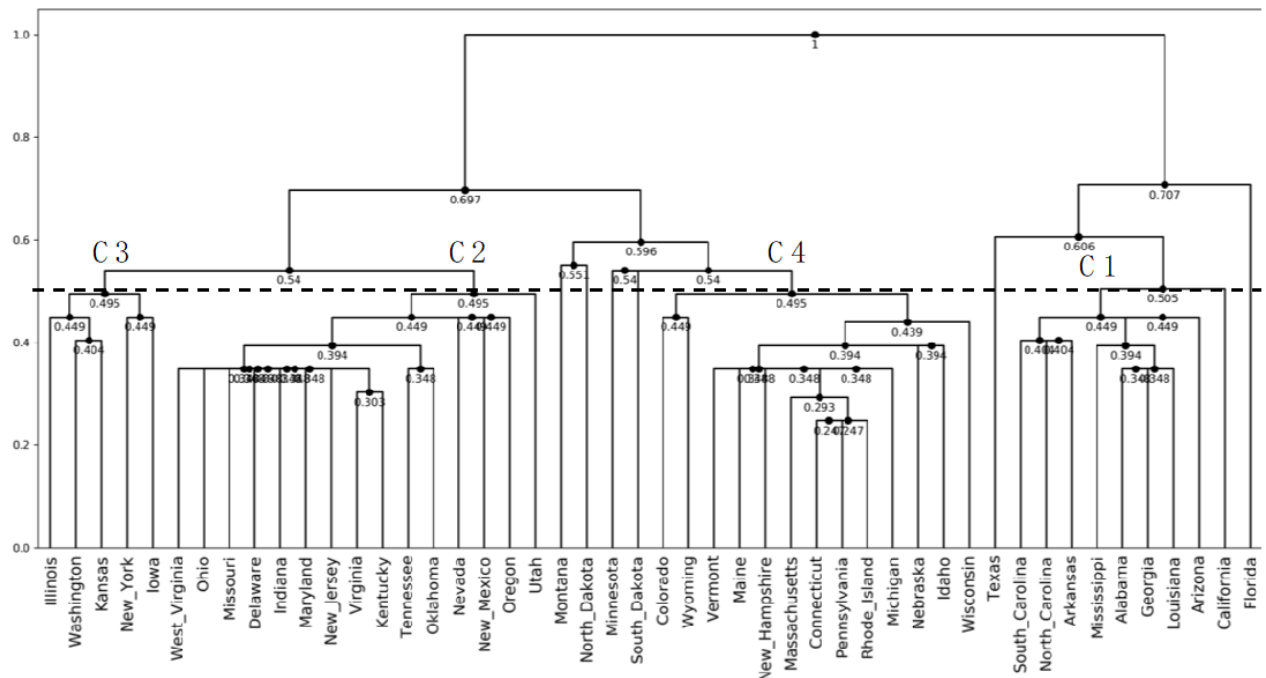
Figure 22. Clustering result of the US state weather data for February and November. Figure 23 is the scatter diagram of eleven distributions including four major clusters and seven outliers. Each bin-rectangle for a cluster is overlapped with bin-rectangles of other clusters and with remaining states. However, the distinctions between clusters and other states are clear from the maximum quantile vectors and/or the minimum quantile vectors. In other words, we can explain the relationships between eleven distributions by using their mutual positions of the maximum and/or the minimum quantile vectors.